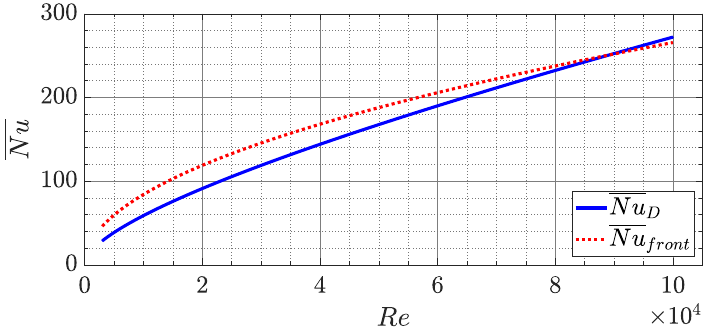
Figure A1. Average Nusselt number estimations for the whole sphere and the front hemisphere in the range 3.0 × 10 3 < Re D < 1.0 × 10 5